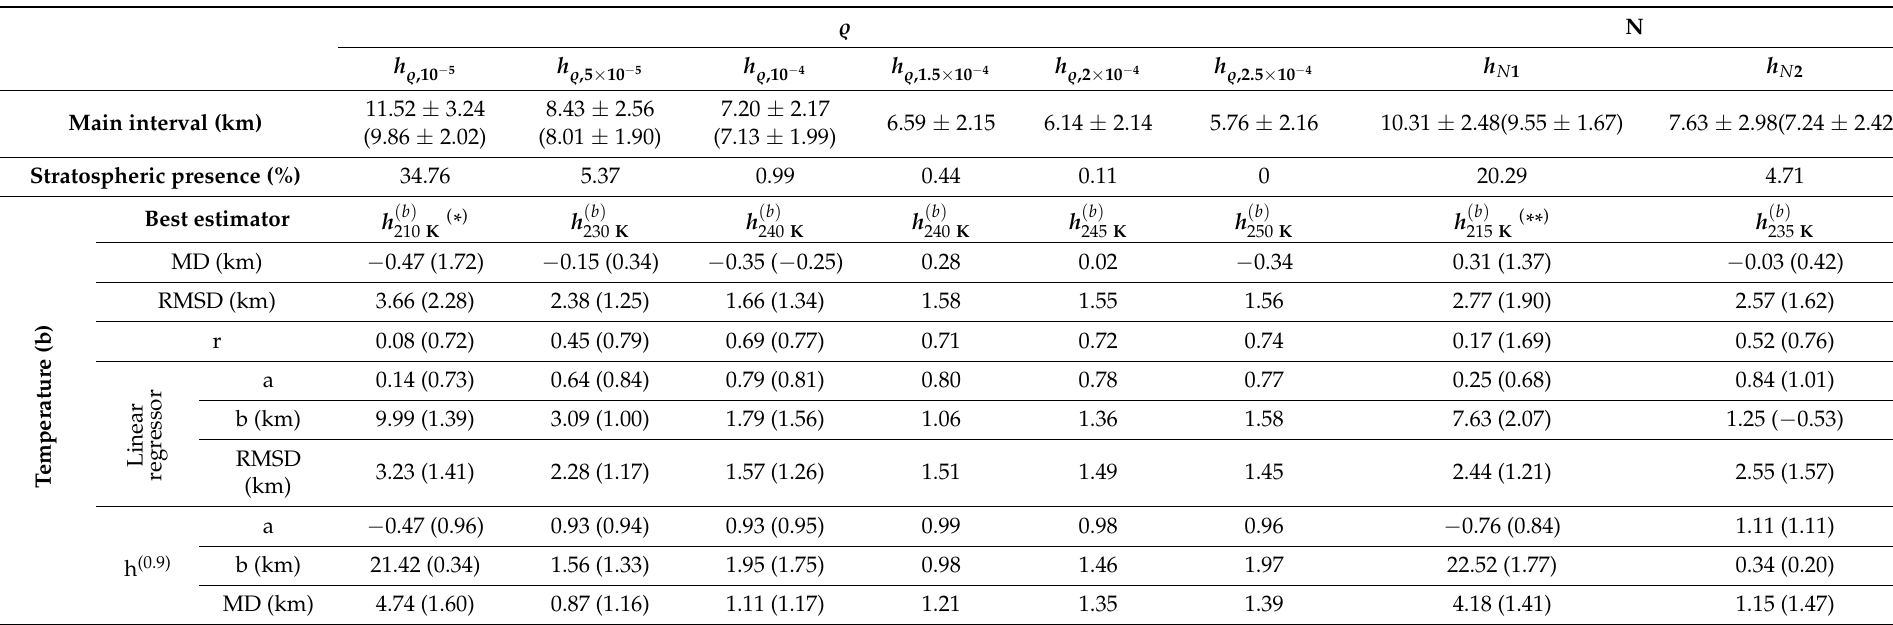
( b ) Table 3. Best estimators of the dry air starting altitudes by the h altitudes, concerning real temperatures. Data below give, in row order: (1) mean value and standard deviation for the T i starting altitude; (2) stratospheric probability for the starting altitude; (3) starting altitude Best estimator; (4), (5), (6) and (7) MD, RMSD and correlation coefficient r between the starting altitude and its Best estimator; (7) and (8) a and b coefficients of the linear regressor h lin . regr . = a · h best est . + b ; (9) RMSD of the linear regressor; (10) and (11) a and b coefficients of the altitude h ( 0.9 ) = a · h best est . + b ; (12) MD of the h ( 0.9 ) altitude. Data obtained by omitting stratospheric altitudes are reported in